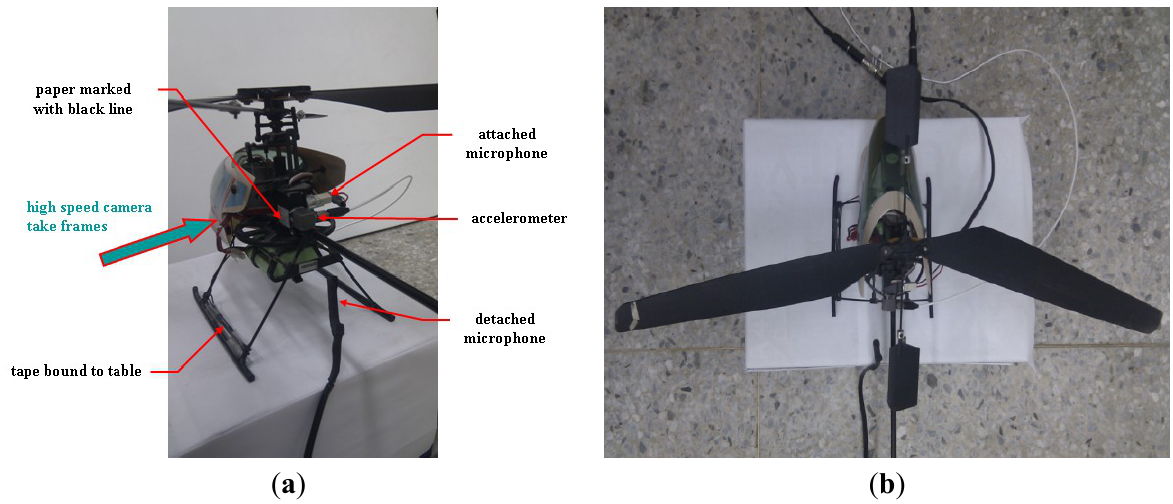
Figure 13. The experimental setup of capturing the signal of a small electric helicopter: ( a ) the overall set up. ( b ) the non-symmetrically main rotor